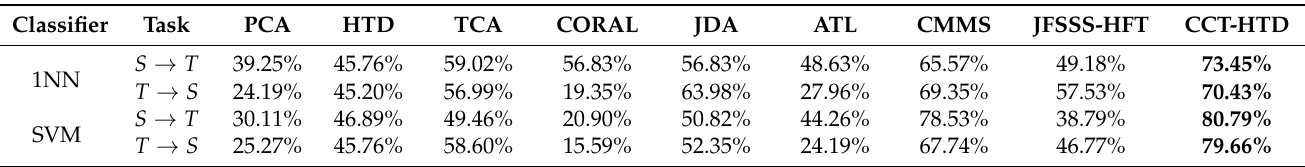
Table 9. Classification accuracies of different domain adaptation methods by adding interference samples with 1NN and SVM using dataset